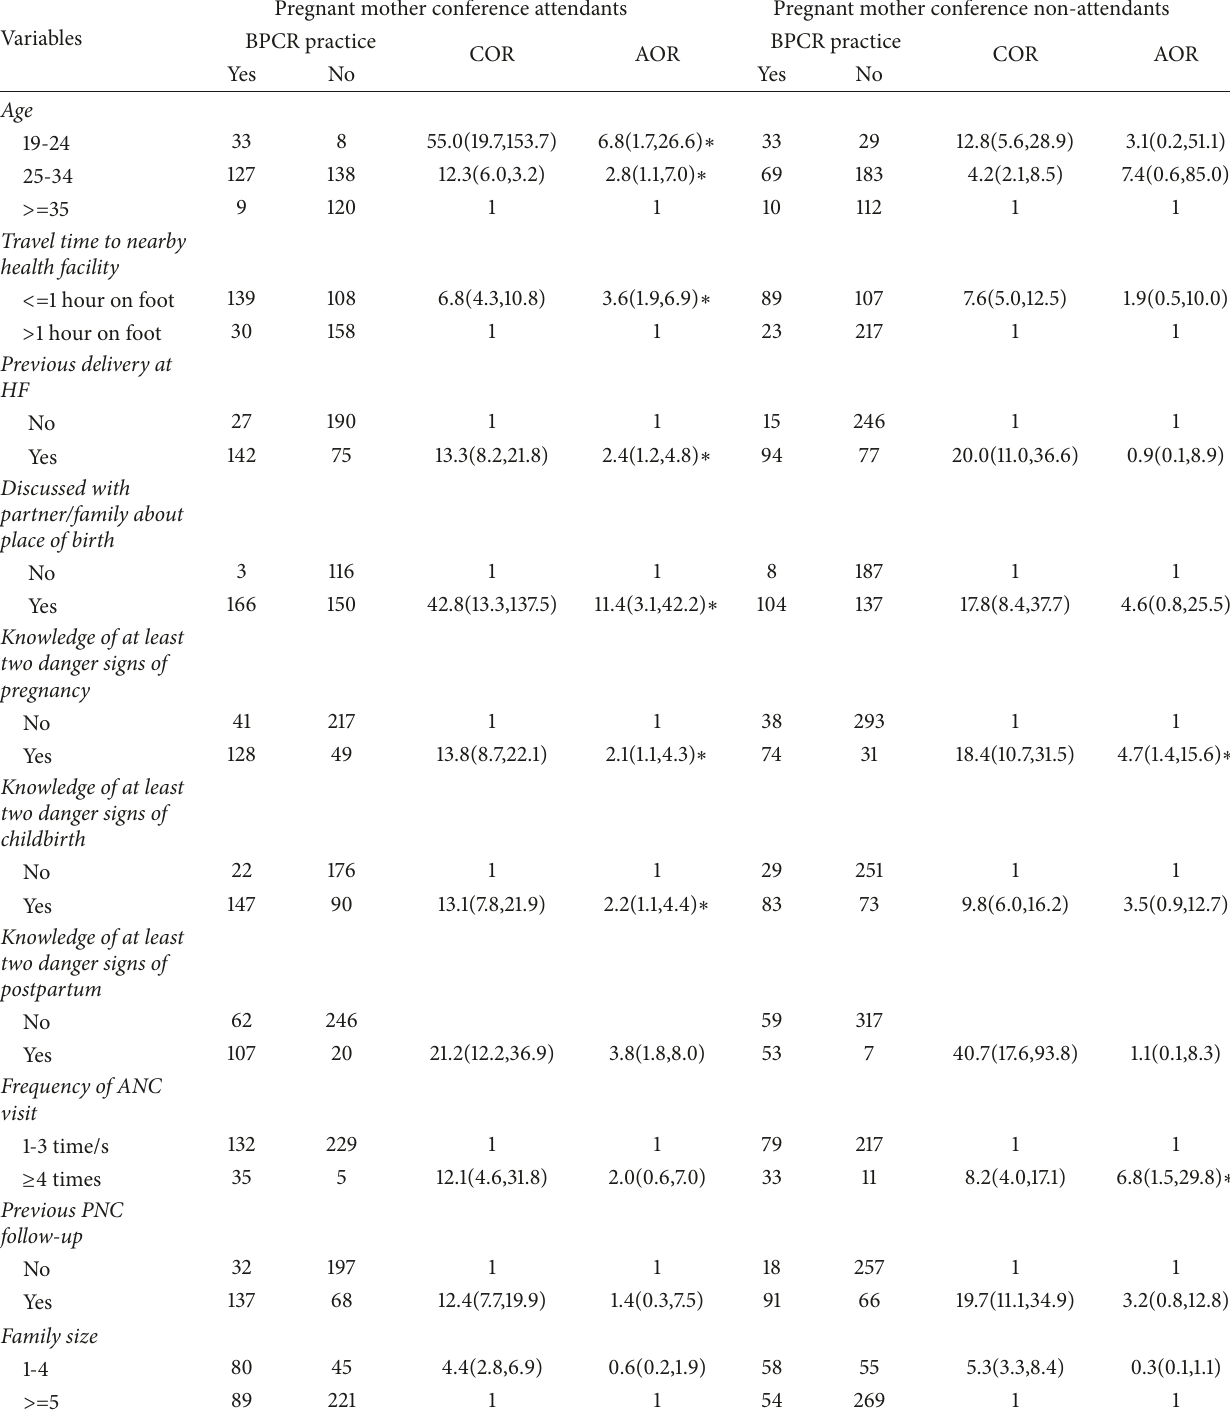
Table 4: Factors associated with BPCR practice among PMC attendant and PMC non-attendant women who gave birth in the past 12 months in Lebo Kemkem District, South Gondar zone, Ethiopia,